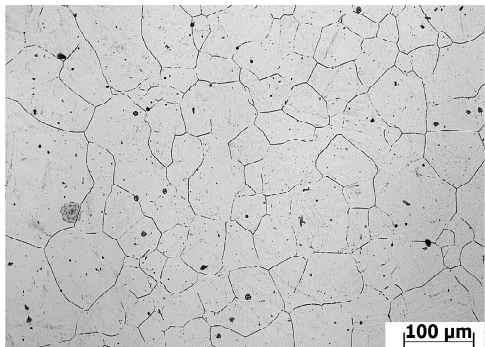
Figure 2. Original microstructure of X12CrMoWVNbN10-1-1 alloy steel.